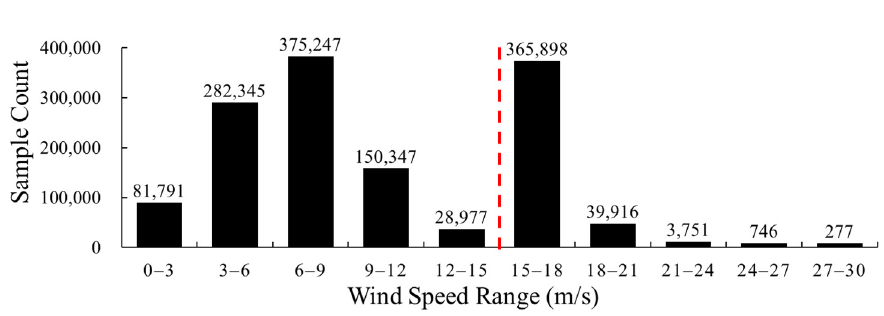
Figure 4. Model construction process and evaluation methods.